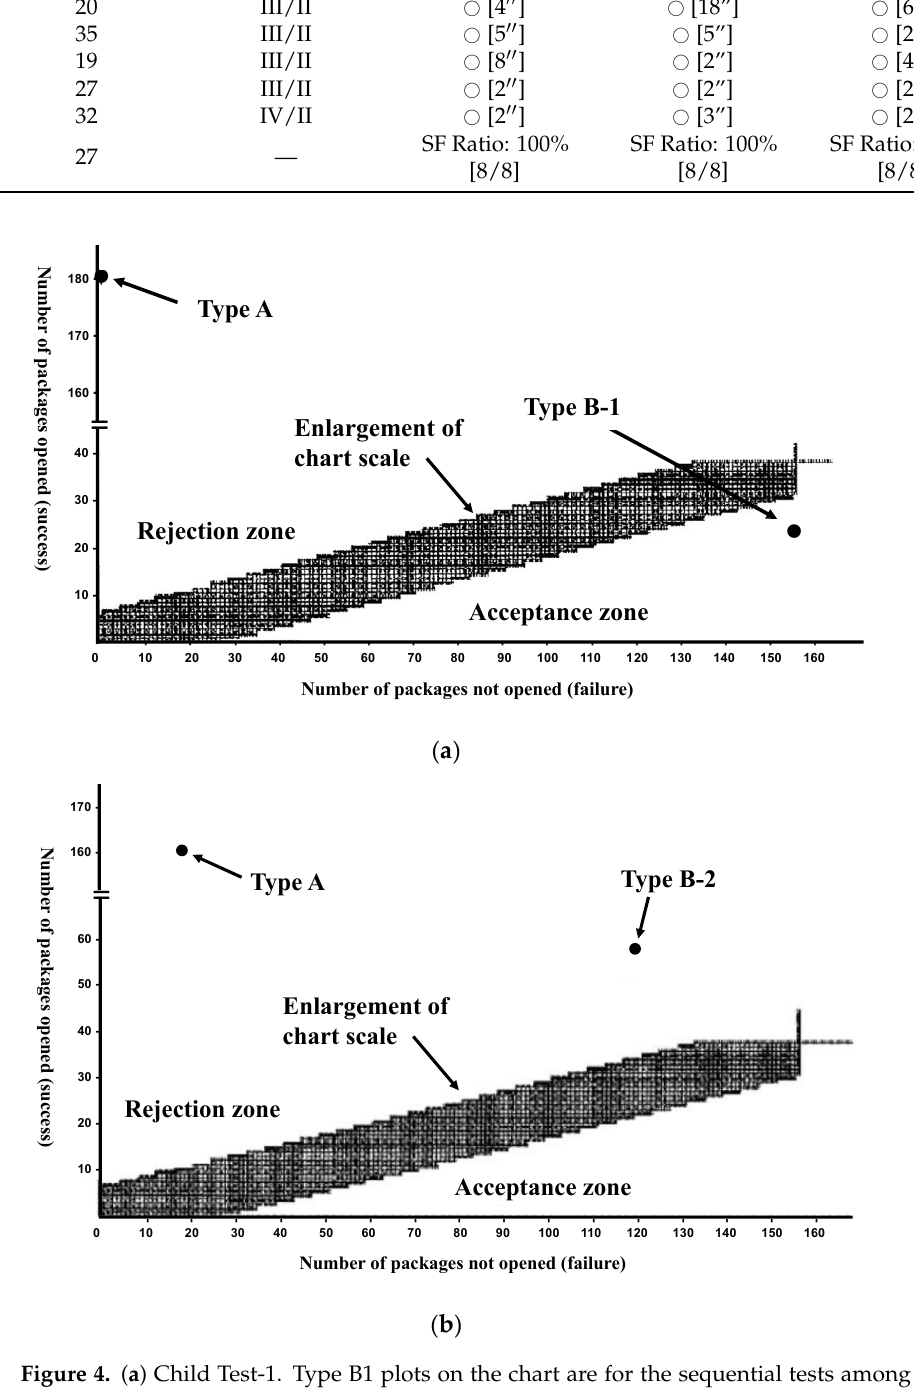
Figure 4. ( a ) Child Test-1. Type B1 plots on the chart are for the sequential tests among children. ( b ) Child Test-2. Type B2 plots on the chart are for the sequential tests among children.